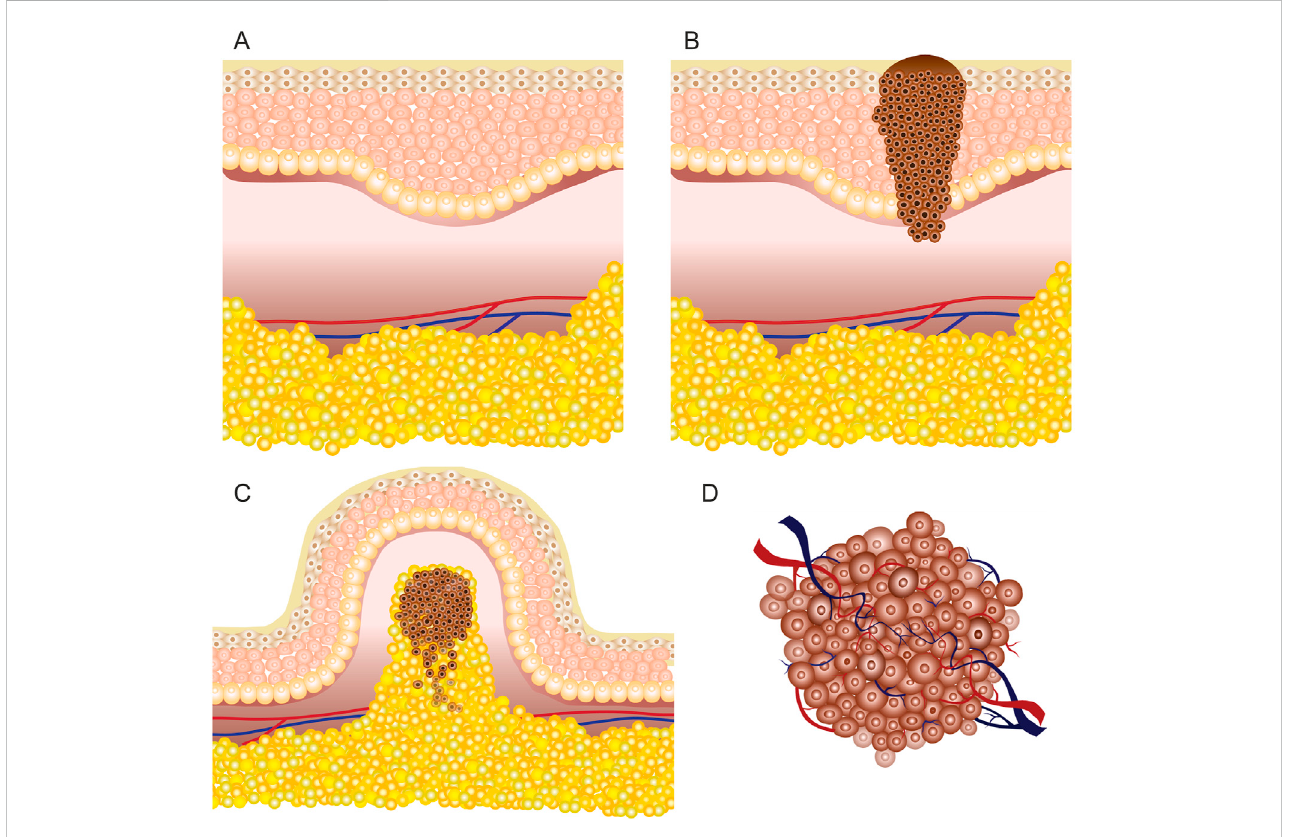
FIGURE 2 Skin illustration: (A) healthy tissue; (B) cutaneous tumor (melanoma); (C) super fi cial or exophytic tumor; (D) deep-seated